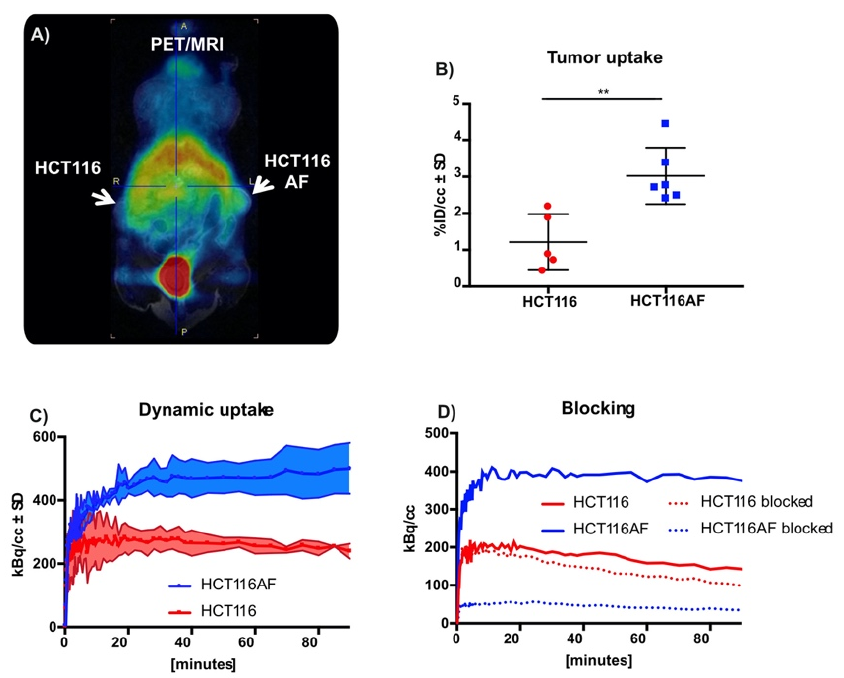
Figure 4. In vivo static and dynamic PET imaging of AF expression: ( A ) PET images of mouse with HCT116 (left) and HCT116AF (right) tumors show higher tracer accumulation in the AF overexpressing tumor compared to the HCT116 controls; ( B ) Quantification of tracer uptake in tumor 50 min post injection revealed values of 3.0 ± 0.77 vs. 1.2 ± 0.77% ID/cc in the HCT116AF and HCT116, respectively ( p < 0.01); ( C ) Dynamic uptake on tracer in HCT116 and HCT116AF tumors shows higher tracer uptake in AF over-expressing tumors at all time-points; ( D ) Treatment of mice ( n = 2) with the non-radioactive reference compound appears to have a strong blocking effect, offering evidence that the tracer is specific to AF (** p < 0.01).